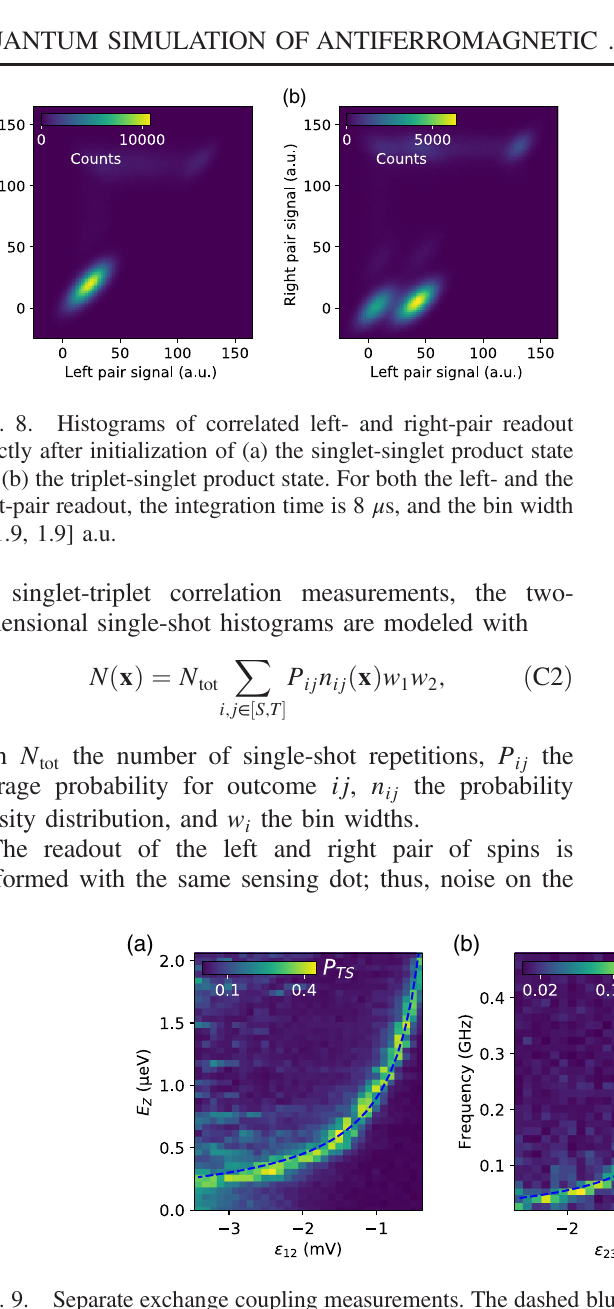
FIG. 9. Separate exchange coupling measurements. The dashed blue lines are fits to the data. (a) Spin funnel on left pair, (b) Fourier transform of triplet-subspace coherent oscillations shown in Fig. 3(c), (c) spin funnel on right pair.